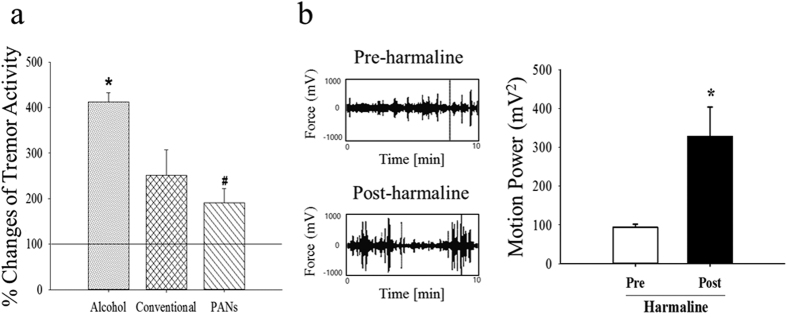
(a) Compared to control diet group (Normal as represented by 100%), alcohol treatment group (Alcohol) showed greatly increased tremor activity. PAN group with acupuncture stimulation at HT7 significantly attenuated alcohol-induced tremor activity compared to alcohol group. (b) Harmaline, a tremor inducer, was given i.p. to assure proper characterization of tremor activity. Note: In (a), *p < 0.05 stands for control and alcohol groups, #p < 0.05 stands for alcohol and PAN groups. In (b), *p < 0.05 stands for post- and pre-harmaline groups.